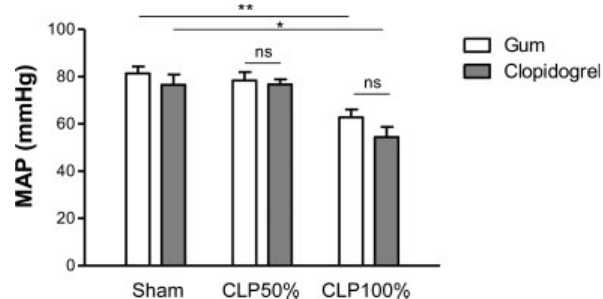
Fig. 1 Clopidogrel treatment does not impact adverse